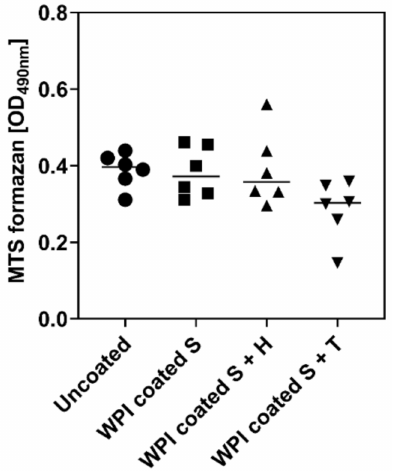
Figure 5. Metabolic activity of hBMSC on bare and coated Ti6Al4V. 6500 hBMSC/sample plated onto bare Ti6Al4V (uncoated) and Ti6Al4V coated with WPI + heparin, and WPI + tinzaparin and analysed after 48 h for metabolic activity. The results are shown as mean (bar) and individual values; n = 3. Statistically significant differences were not